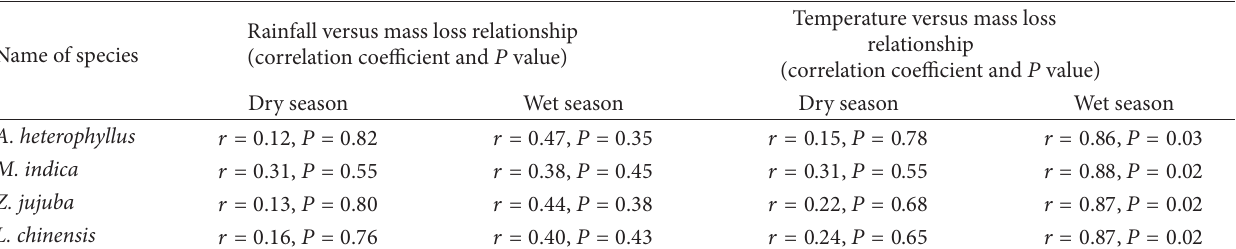
Table 3: Relationship among rainfall and temperature with mass loss of leaf litter of selected cropland agroforest horticultural tree species (dry and wet season).